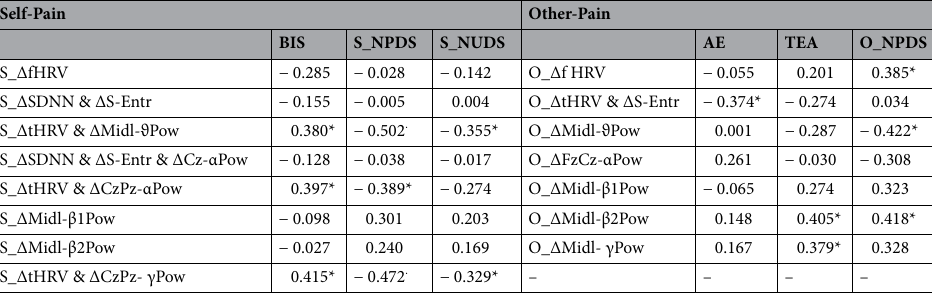
Table 5. Left-half table: Partial Pearson correlation coefficients of the Behavioral Inhibition System (BIS) personality trait and numerical pain and distress difference scores (Control minus Placebo) in the self-pain (S_NPDS, S_NUDS) condition with HRV and EEG band power difference (∆, Control minus Placebo) factors of interest. Right-half table: Partial Pearson correlation coefficients of Affective Empathy (AE), Total Empathy Ability (TEA), and numerical pain difference scores in the other-pain condition (O_NPDS) with physiological difference factor scores showing significant associations. The effect of Gender and State Anxiety changes (Control minus Placebo) was partial out. · p < 0.01; *p < 0.05; (False Discovery Rate correction). S_: self-pain; S_∆fHRV: frequency HRV difference score; S_∆SDNN & ∆S-Entr: Standard deviation of R–R intervals & Sampling Entropy differences; S_∆tHRV & ∆Midl-ϑPow: R–R time interval & Midline ϑ band power differences; S_∆SDNN & ∆S-Entr & ∆Cz-αPow: Standard deviation of R–R intervals & Sampling Entropy & Central (Cz) α band power differences; S_∆tHRV & ∆CzPz-αPow: R–R time interval & Centro-Parietal (CzPz) α band power differences; S_∆Midl-β1Pow: Midline β1 band power differences; S_∆Midl-β2Pow: Midline β2 band power differences; S_∆tHRV & ∆CzPz- γPow: R–R time interval & Centro-Parietal (Cz and Pz) γ